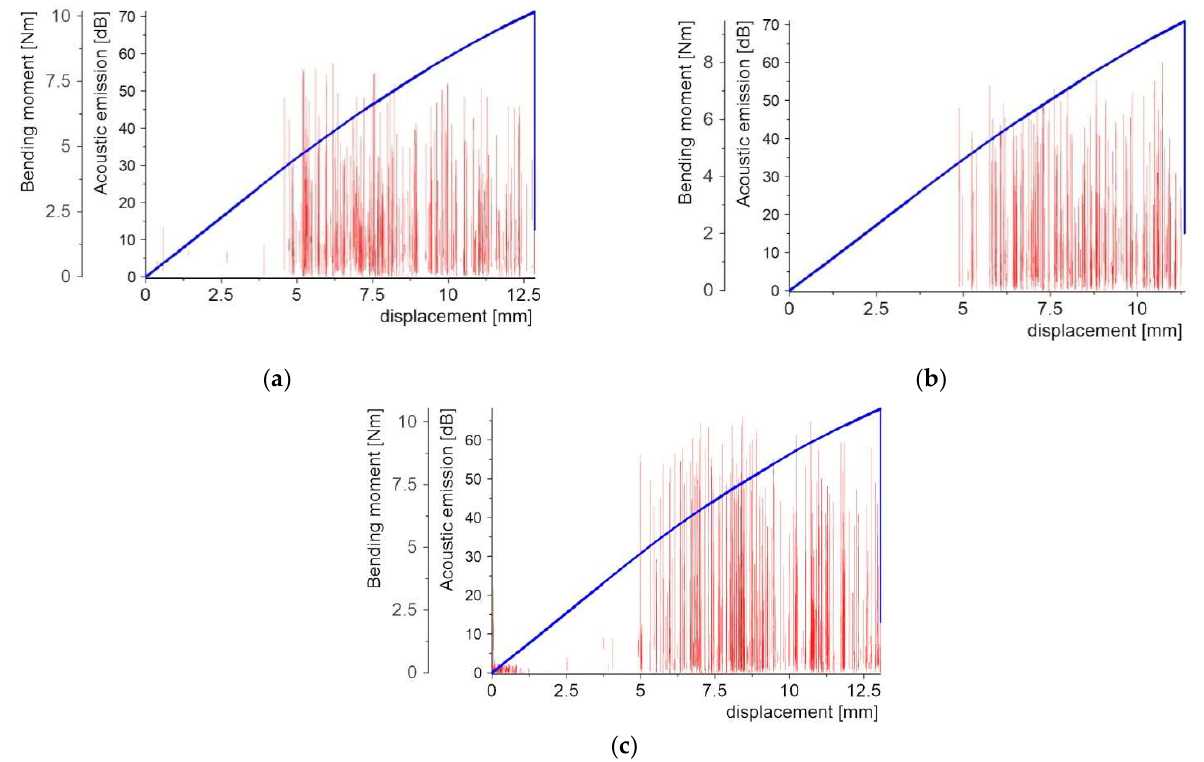
Figure 13 . 2. Numerical Simulation Results of the Cracking Process in the Central Part of the Speci- Figure 13. Bending moment and AE vs. displacement plots for specimens with microballoon layer: men Subjected to 3-PB. ( a ) 6_1, ( b ) 6_2, ( c ) 6_3. ( a ) sample 6_1; ( b ) sample 6_2; and ( c ) sample